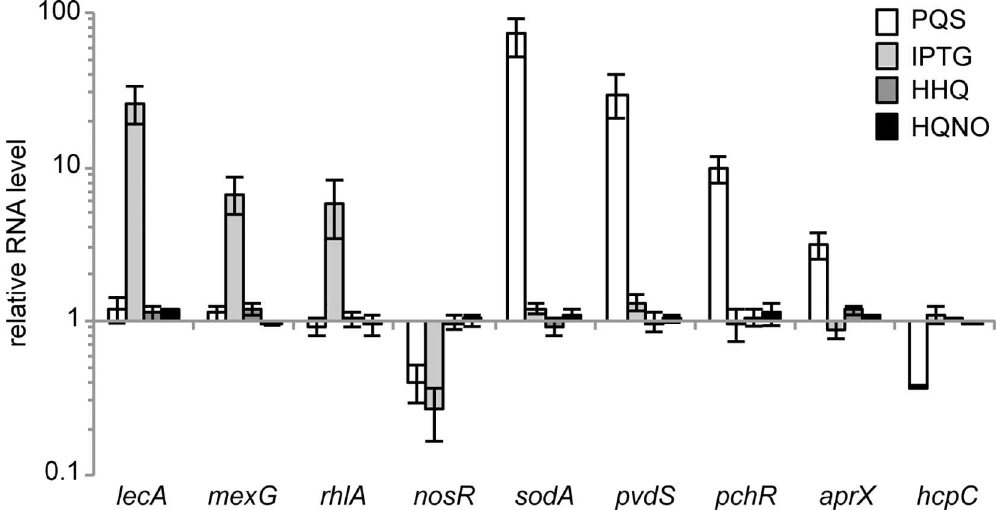
Fig 4. Validation of the microarray data by Real Time PCR. RelativemRNA levels of the genes indicated quantifiedby Real Time PCR in the P . aeruginosa Δ 4AQ strain grown in LB supplemented with 1 mM IPTG to induce PqsE expression(light-grey bars), or with 40 μ M PQS (white bars), HHQ (dark-grey bars), or HQNO (black bars), with respect to the same strain grown in LB. The averageof two independent analyses each performed on three technical replicatesis shown with standard